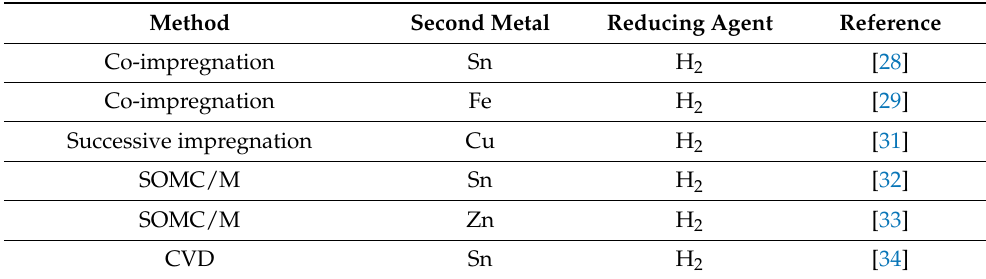
Table 1. Preparation methods of Ni-based bimetallic